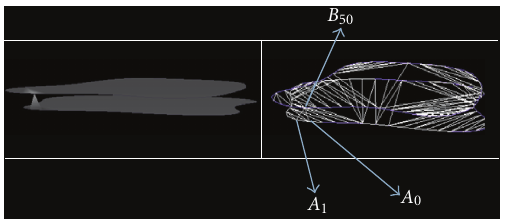
Figure 13: A 0 : starting point.